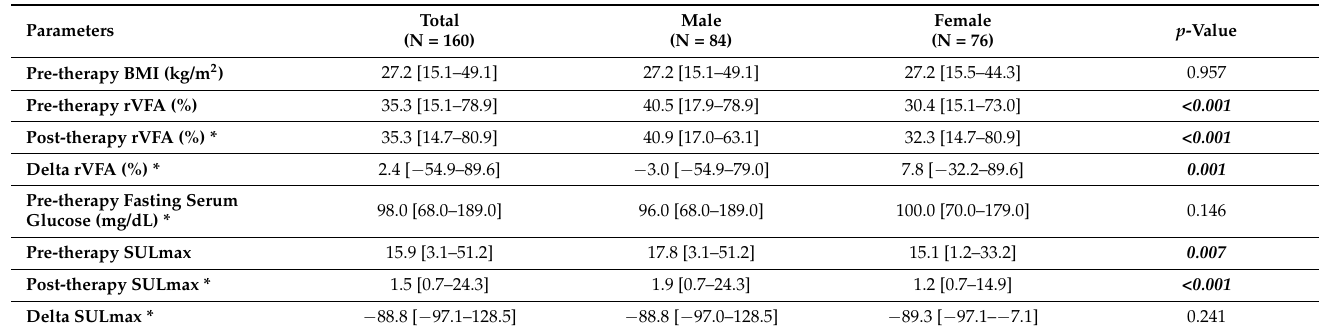
Table 2. Summary of Patient Metabolic